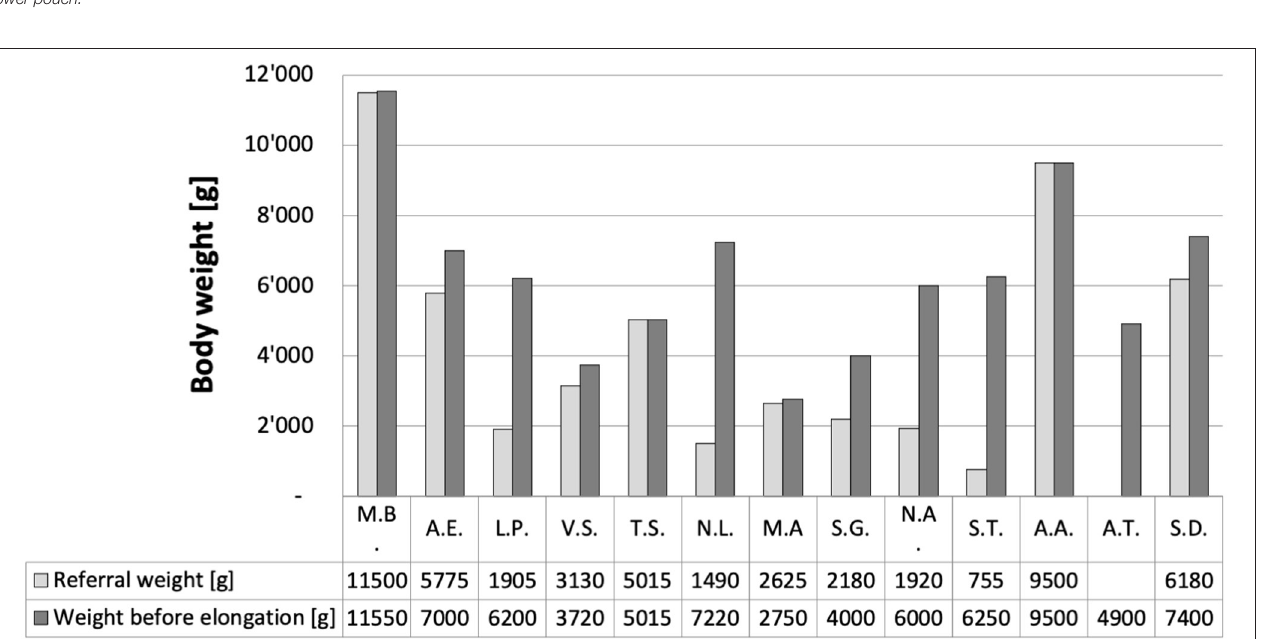
fistula of the upper pouch via a right cervical approach on day 51 of